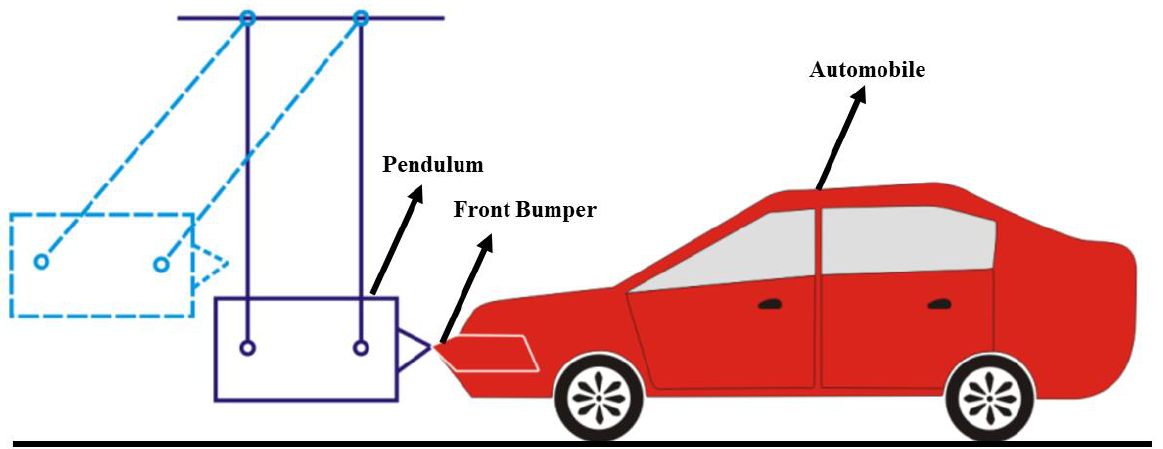
Figure 4. Low-speed impact test [20].